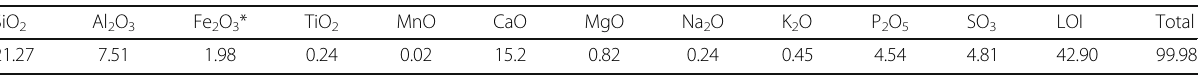
Table 1 Chemical analyses of the used sample in weight % SiO 2 Al 2 O 3